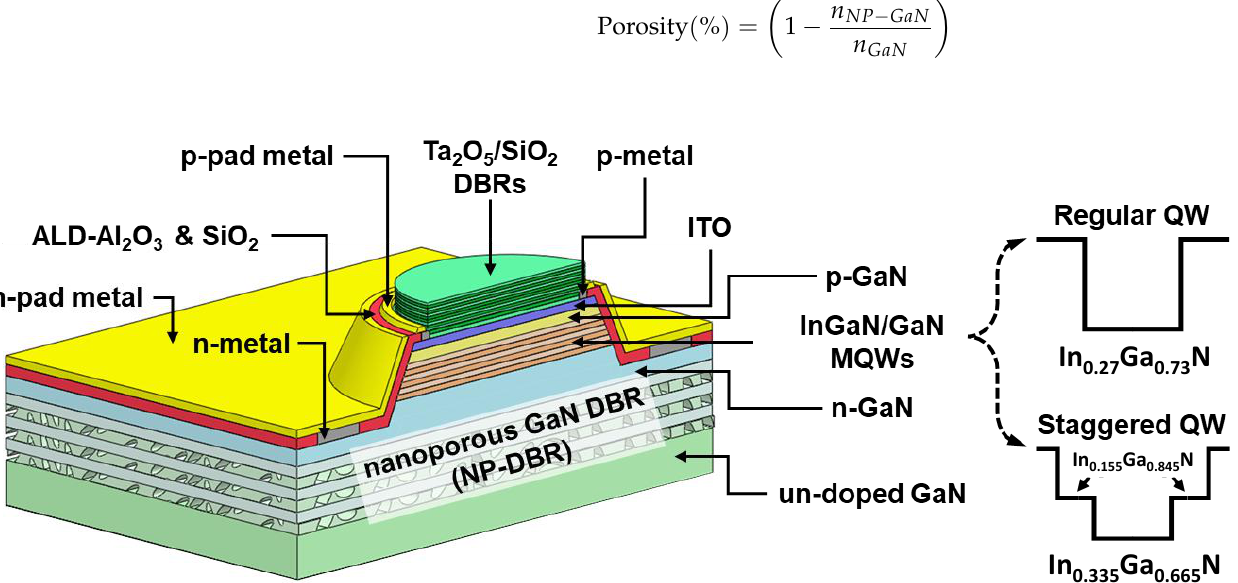
Figure 5. 3D schematic of the InGaN-based green μ-RCLED with regular or staggered MQWs. The mesa diameter and the total height of the μ-RCLEDs are 50 μm and 1 μm, respectively.